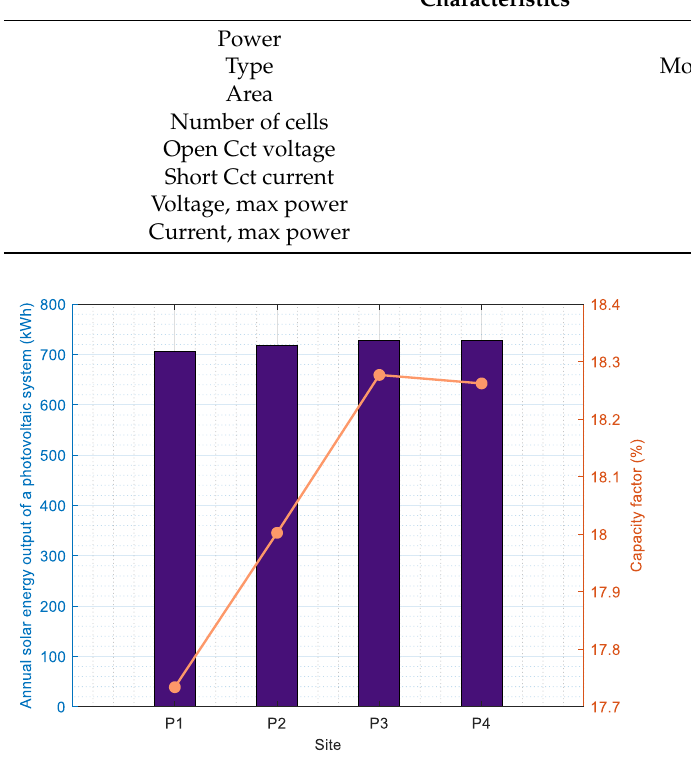
Figure 7. The annual energy production of the PV of 540 W and the capacity factor for the four